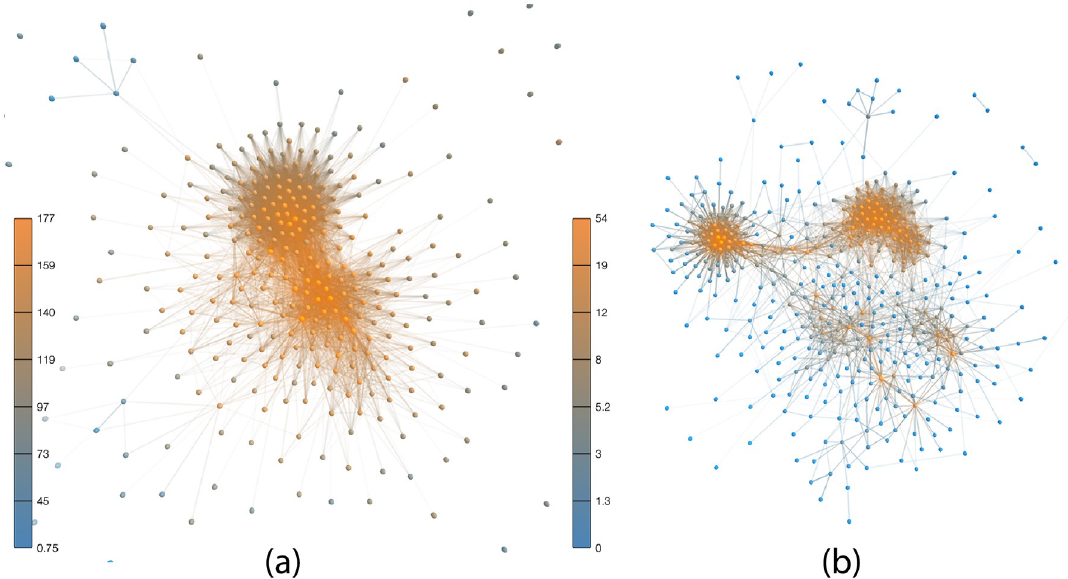
Fig 2. Network obtained considered all proposition voted in 2012. The networks were constructed (a) without edge pruning; and (b) with edge pruning. Each node represents a member from the Brazilian lower chamber. Two members are linked if they voted in a similar way. Colors represent nodes degree. This visualization was created using the Networks3D visualizer software [19].